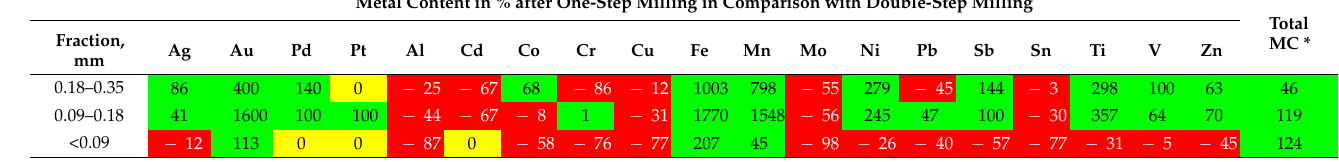
Table 4. MC changes (in %) from double (X1 (>2.8) + X2) to one-step (X1) milling PCB by